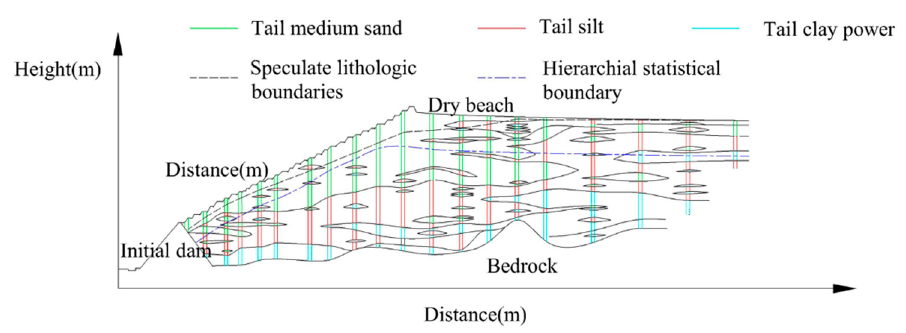
Figure 2. The dam sectional